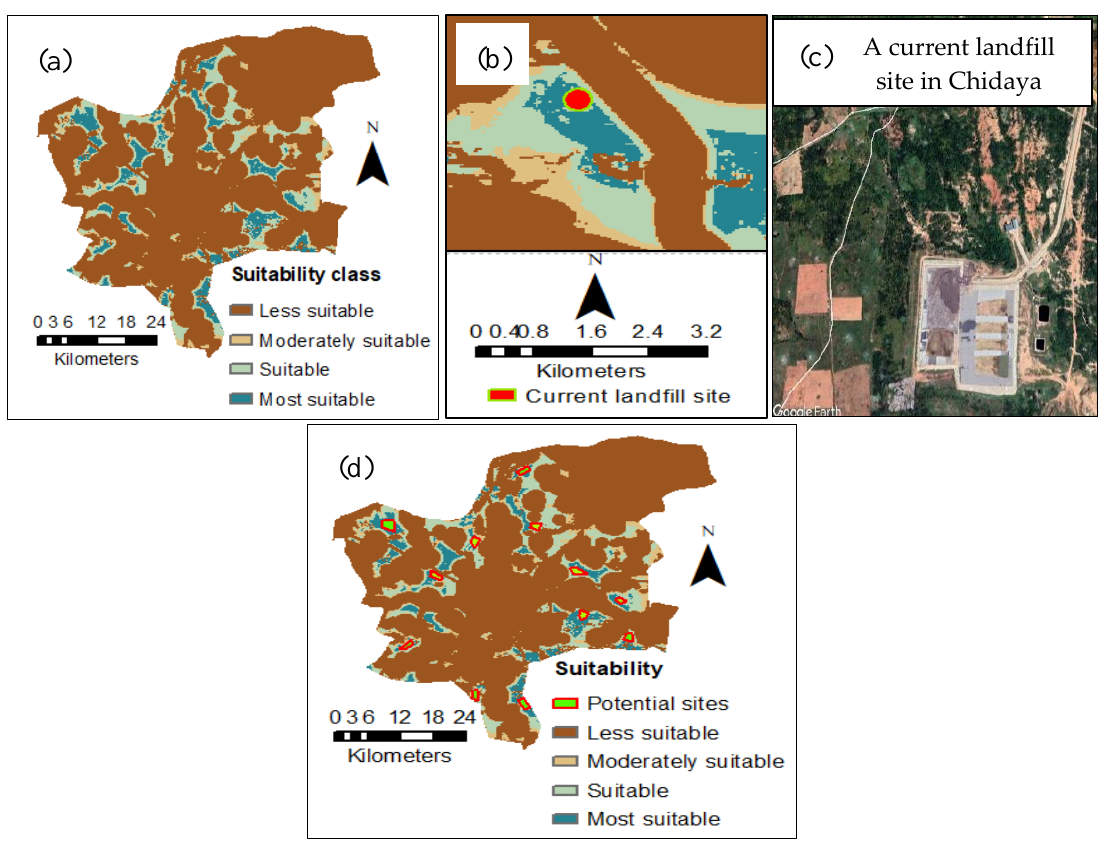
Figure 6. Final landfill suitability map for scenario 6 where α = 0.9. Table 4. A Pairwise comparison matrix.